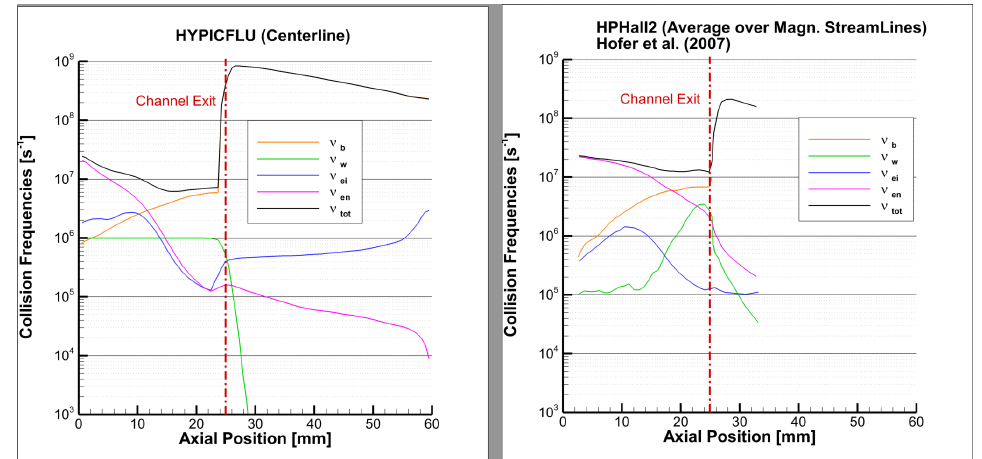
Figure 17. SPT-100 discharge: time-averaged collision frequency contributing to mobility as a function of axial position. Comparison between HYPICLFU (Test 106: data taken along channel centreline) and HPHall2 [17] (data averaged over magnetic streamlines).